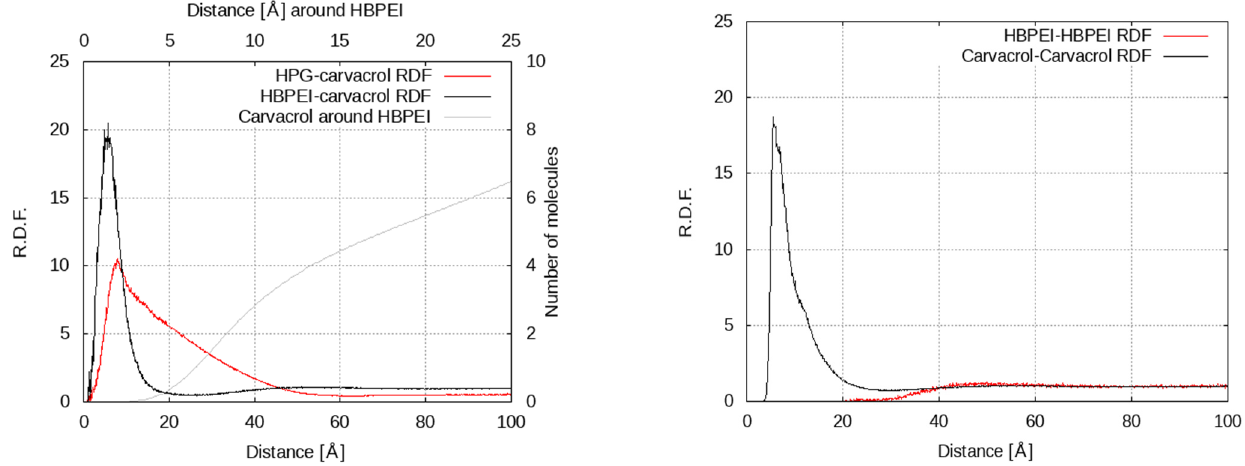
Figure 4. On the left, polymer–carvacrol radial distribution functions for 27-polymer chain systems of HBPEI–carvacrol (red) and HPG–carvacrol (black) mixtures; the number of carvacrol molecules around a HBPEI molecule (grey) is also shown for distances up to 25 Å, using different axes (upper x-axis and right y-axis). On the right, polymer–polymer and carvacrol–carvacrol radial distribution functions for 27-polymer chain systems of HBPEI–carvacrol.